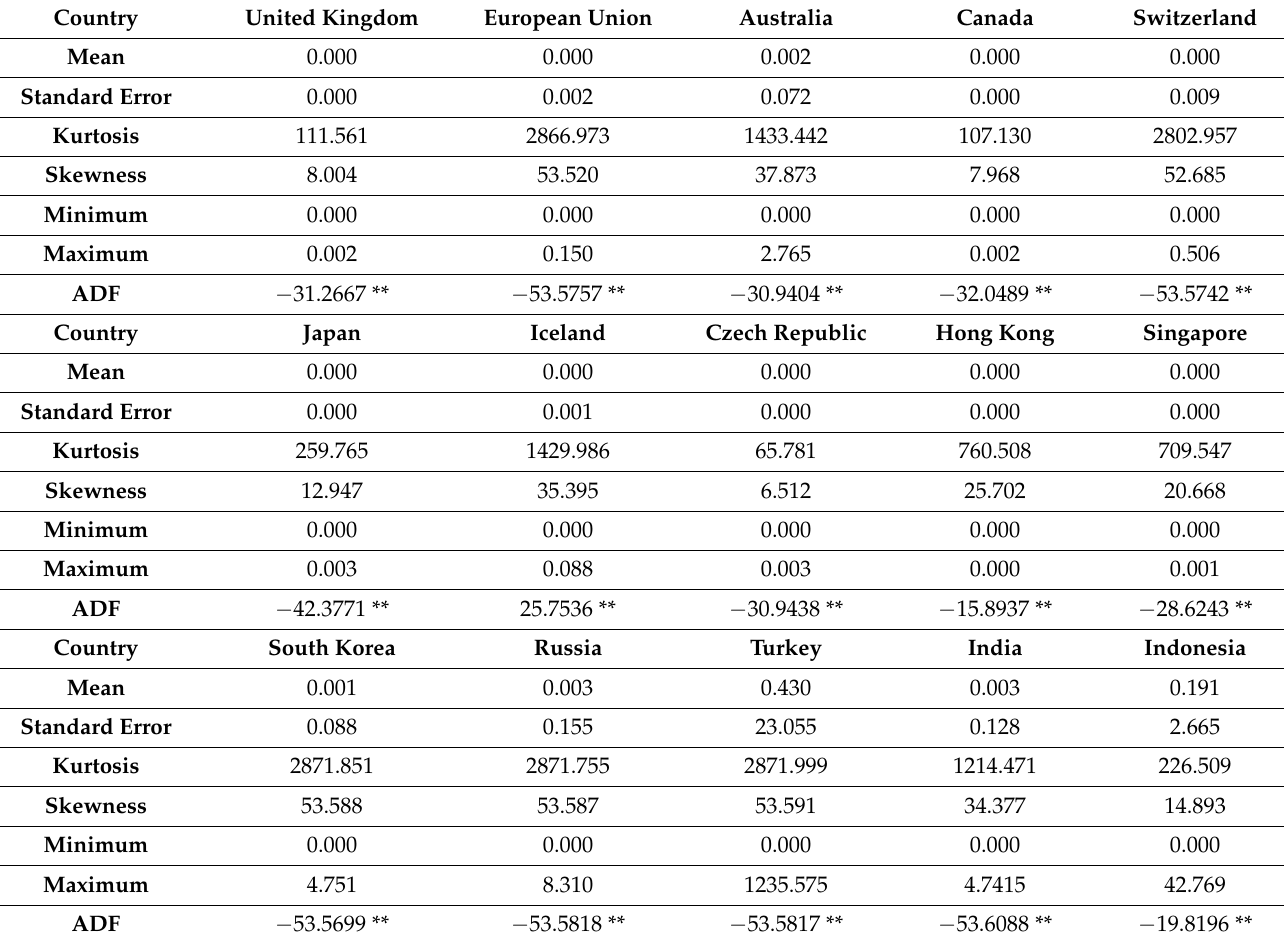
Table 2. Descriptive statistics, global foreign exchange market volatility,